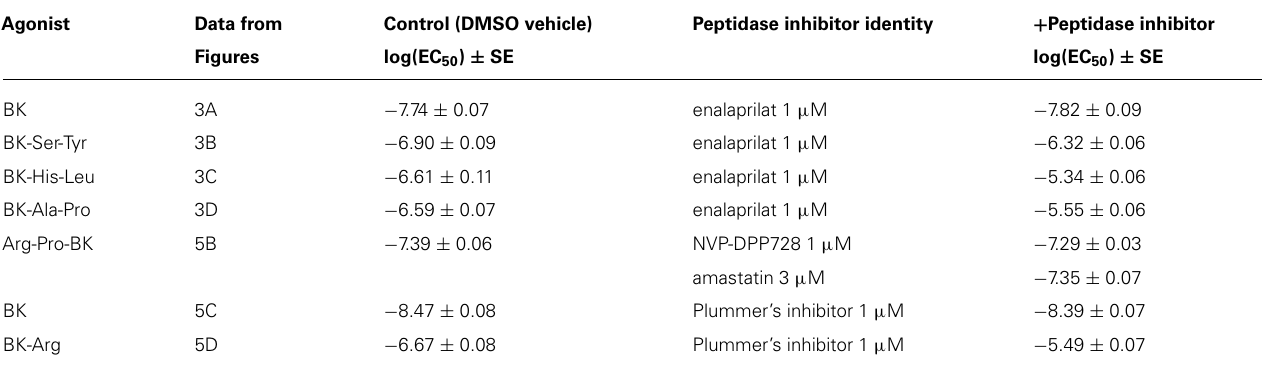
Table 2 | Parameters derived from contractility assays in the human umbilical vein.